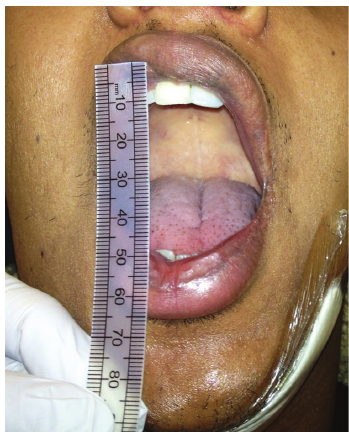
Figure 5: 2-week postoperatively. Note the 40mm interincisal distance and unrestricted mouth